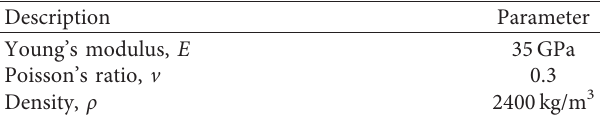
Table 3: Concrete parameters adopted in finite element analysis.